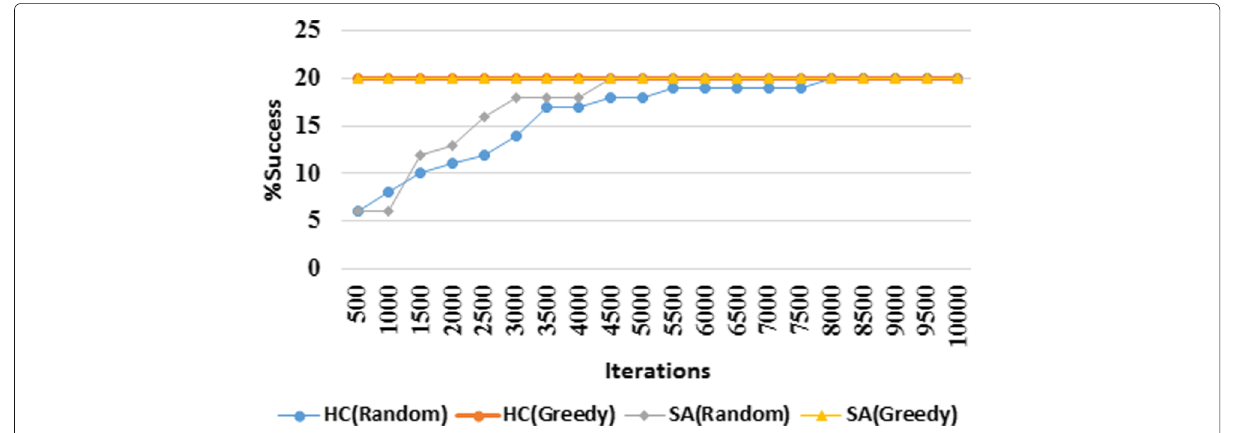
Fig. 8 Run Length Distribution for Small Instance (C(4-5-4))